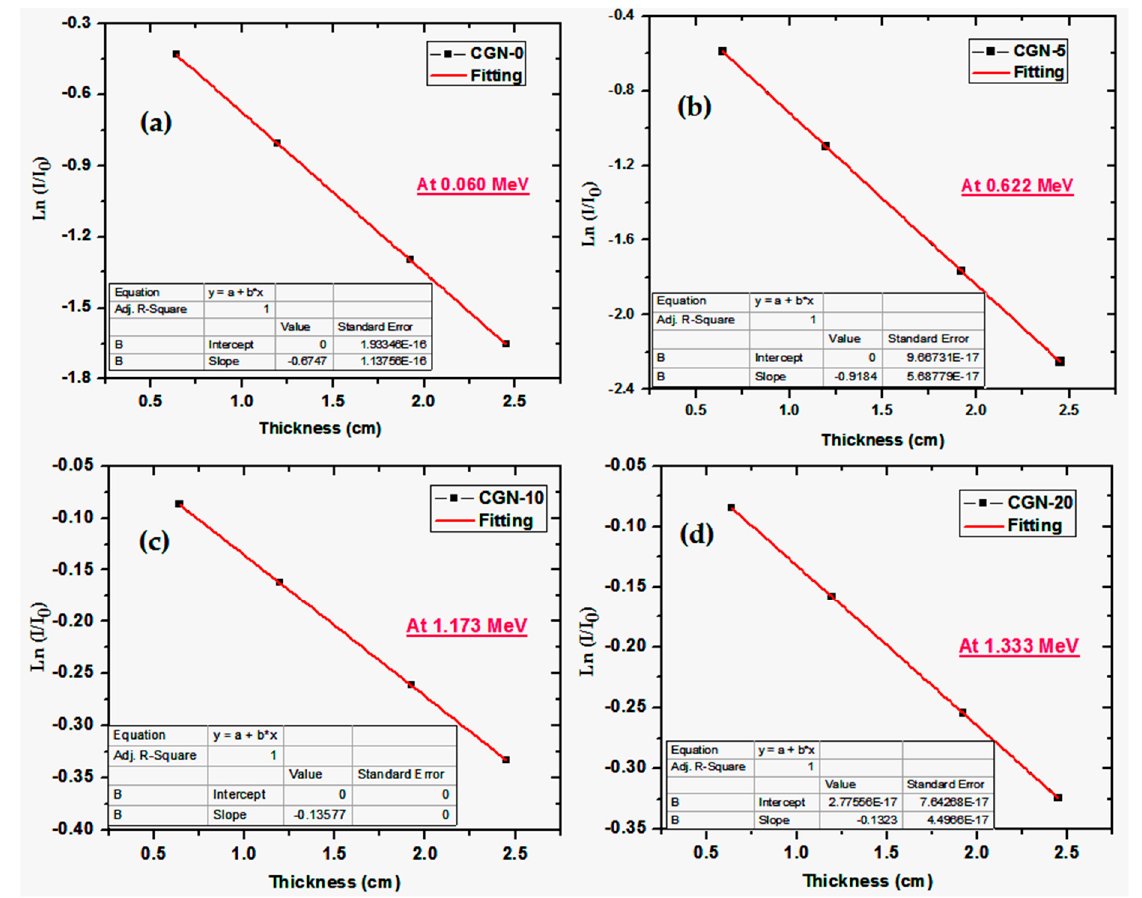
Figure 8. The relation between Ln (I/I 0 ) and the mortar thickness. ( a ) For CGN-0 sample at 0.060 MeV, ( b ) for CGN-5 sample at 0.662 MeV, ( c ) for CGN-10 sample at 1.173 MeV, and ( d ) for CGN-20 sample at 1.333